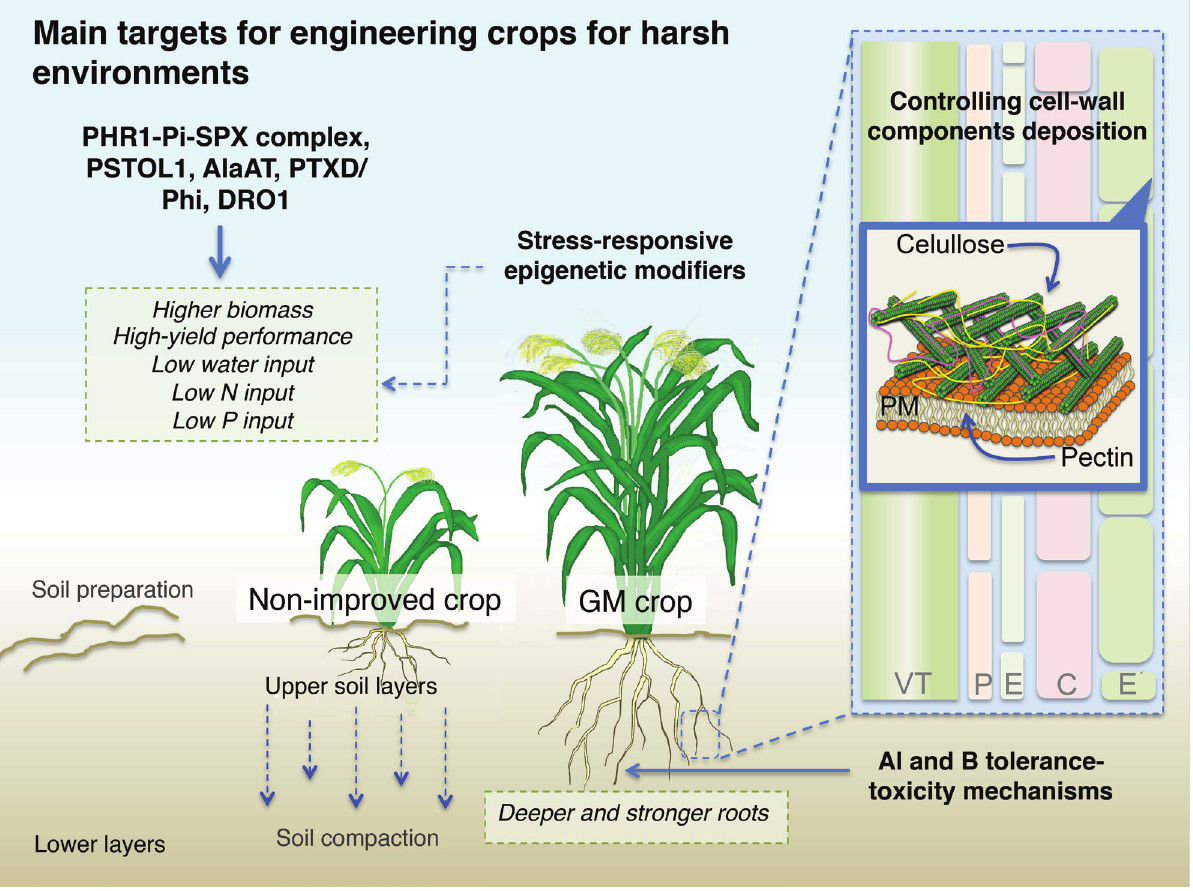
Figure 1. Main targets for engineering crops for harsh environments. Engineering DRO1, AlaAT, PSTOL1, PTXD/Phi and the PHR1-Pi-SPX complex represent interesting approaches with the potential to improve crops for harsh environments. In addition, the identification and manipulation of genes involved in cell-wall components synthesis and stress-responsive epigenetic modifiers has great potential for developing optimal root systems and the improvement of plant responses to diverse stimuli. The simultaneous manipulation of some of these elements could bring robust effects to develop crops with high-yield performance, with a consequent decrease in P- and N-fertilizers input. C, cortex; E, endodermis; E´, epidermis; P, pericycle; VT, vascular